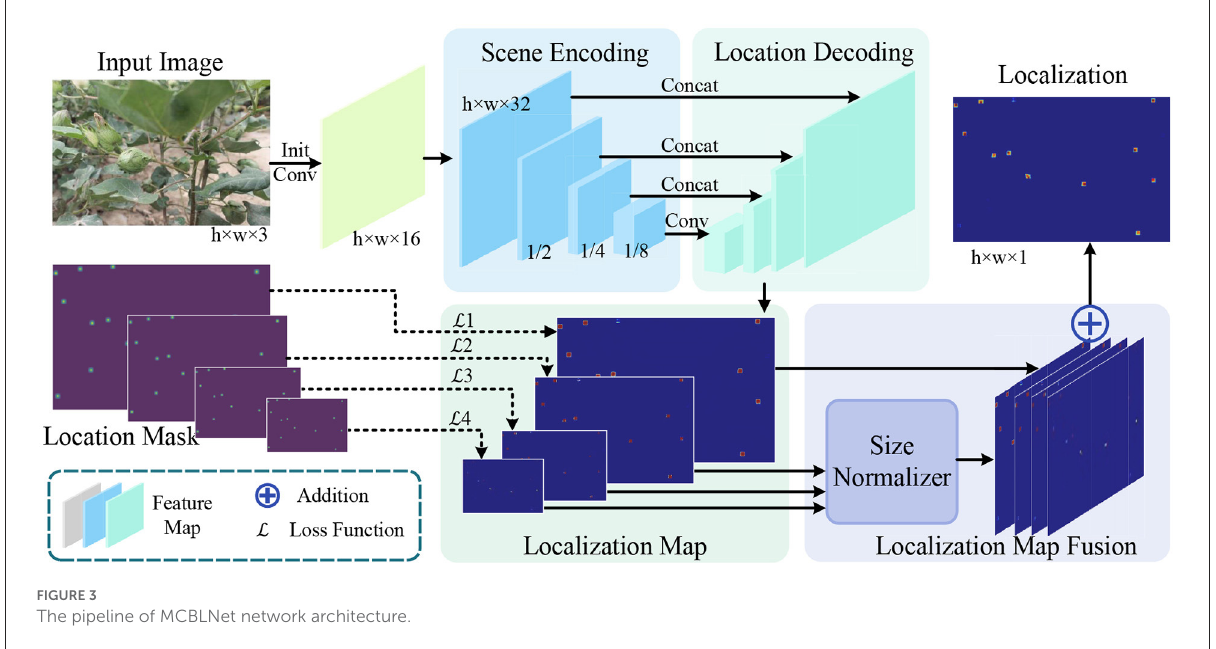
FIGURE3 The pipeline of MCBLNet network architecture.